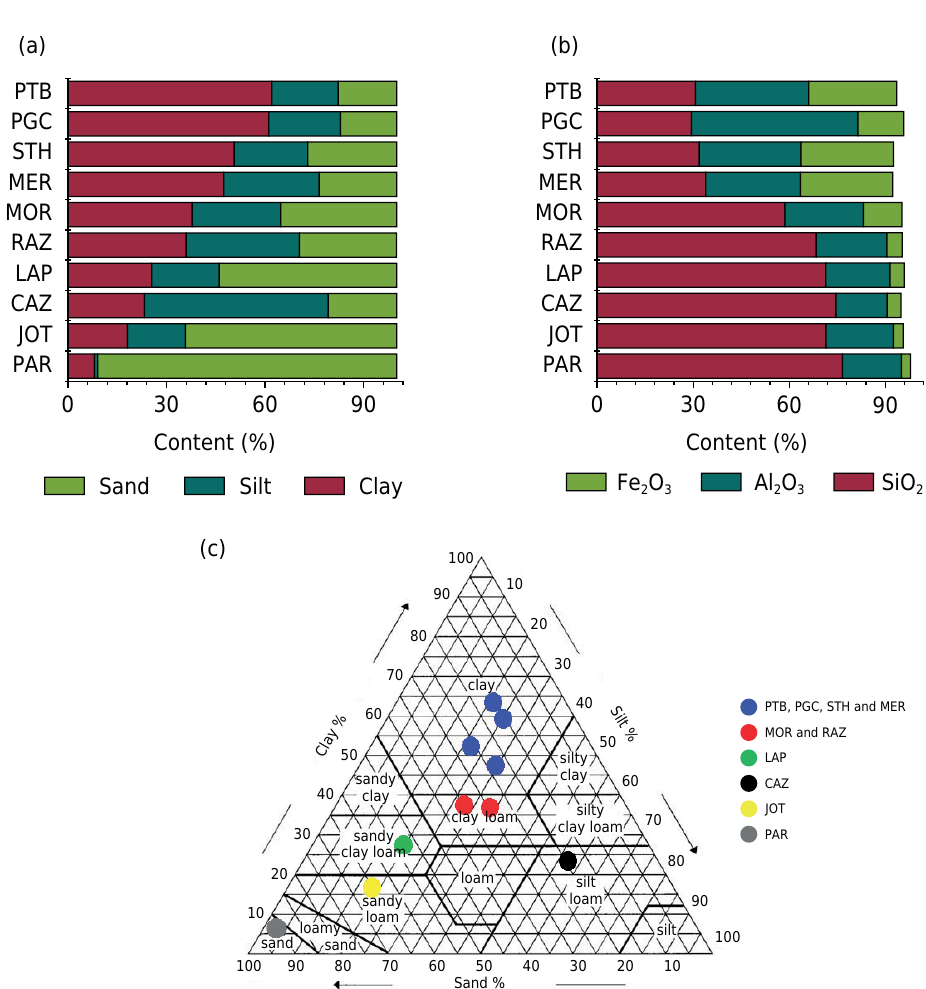
Figure 4. Sand, silt, and clay contents (a), Fe 2 O 3 , Al 2 O 3 , and SiO 2 contents (b), and the distribution of soil types based on percent sand, silt, and clay in the USDA texture triangle classification system (c). The acronyms utilized stand for the following municipalities: PTB (Pato Bragado), PGC (Ponta Grossa), STH (Santa Helena), MER (Mercedes), MOR (Morretes), RAZ (Rio Azul), LAP (Lapa), CAZ (Cerro Azul), JOT (Joaquim Távora), and PAR (Paranavaí).